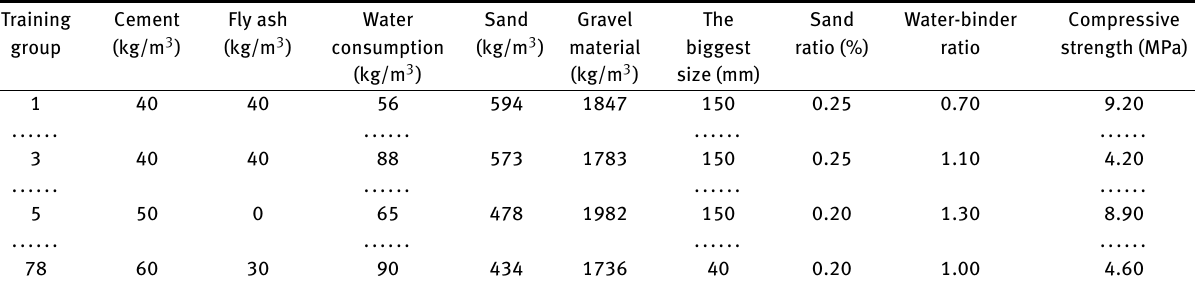
Table 3: BP neural network training sample data Training